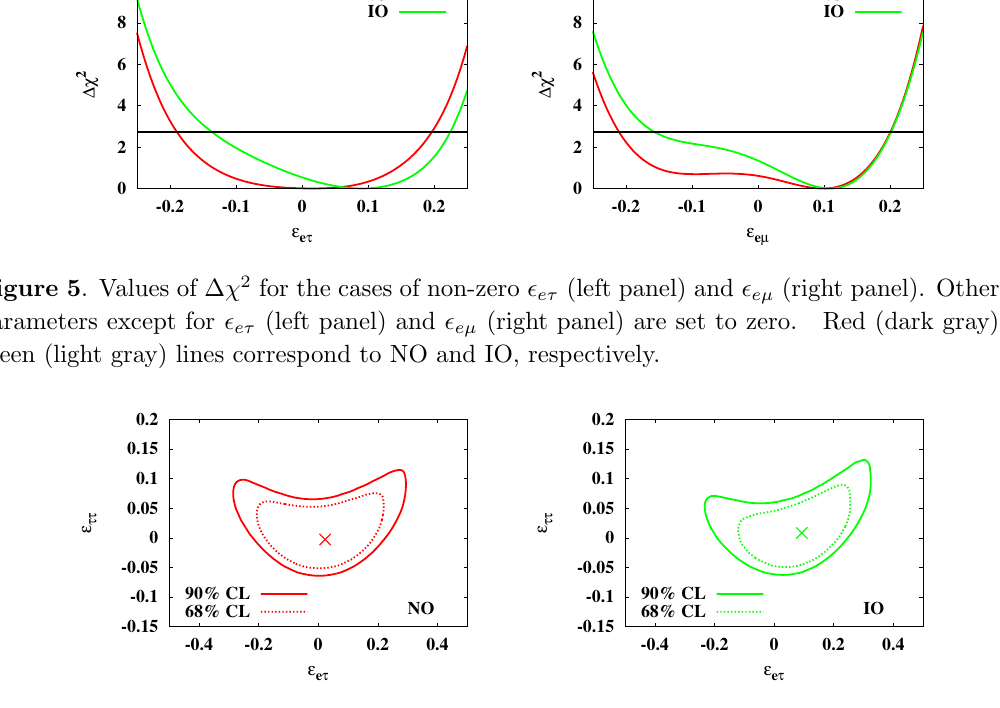
Figure 6 . Allowed regions for the parameters (cid:15) e(cid:28) and (cid:15) (cid:28)(cid:28) for NO (left panel) and IO (right panel). Other parameters of the matter NSI including (cid:15) ee are set to